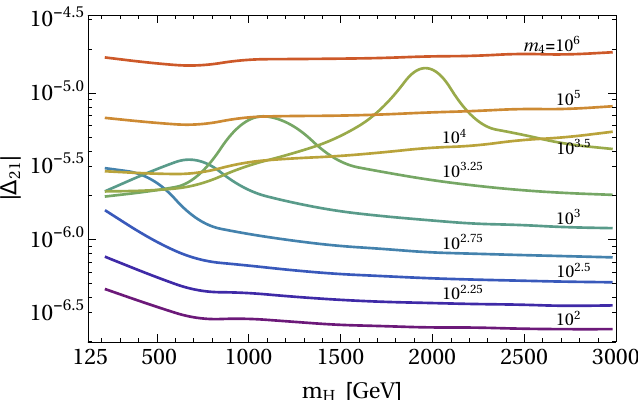
Figure 8 . (Color online) The median of j (cid:1) 21 j as a function of m H for the (cid:12)xed values of m 4 as displayed in the plot close to each line. The values were calculated in intervals of (cid:1) m H = 250 GeV and splined. (cid:21) D = 1 is (cid:12)xed for all curves. Each line contains the statistical information from more than 150.000 parameter points that are taken in the respective range of m H , but varying over m A , ( (cid:12) (cid:0) (cid:11) ), and the allowed values of (cid:30) 0